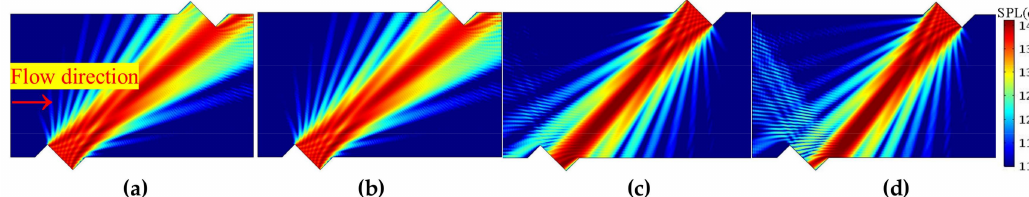
v = 12.82 m/s. ( b ) Downstream, v = 31.86 m/s. ( c ) Upstream, v = 12.82 m/s. ( d ) Upstream, v = 31.86 m/s.